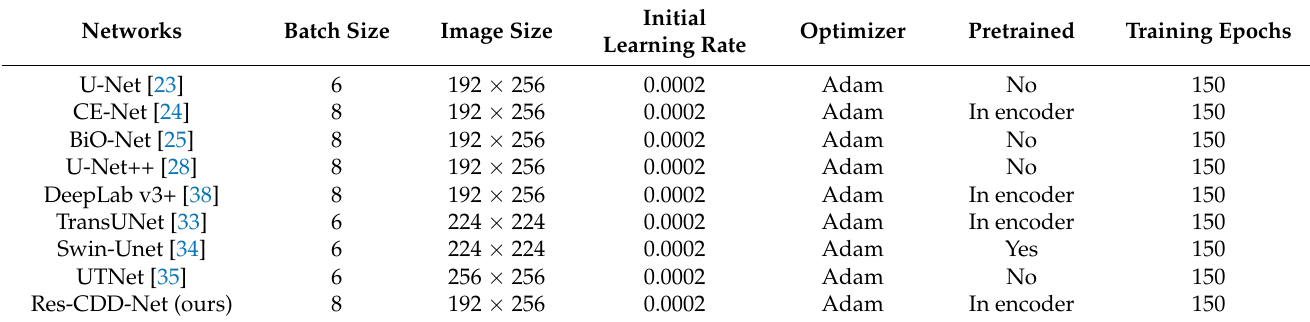
Table 2. Details of configurations of different networks.